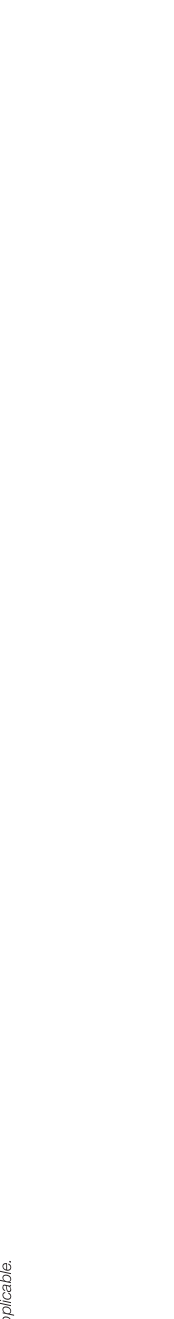
FIGURE 2 | States from where studies were reported.